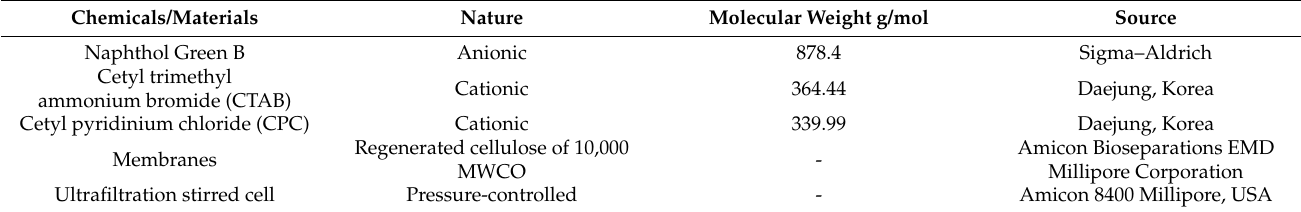
Table 8. Required details of chemicals and materials